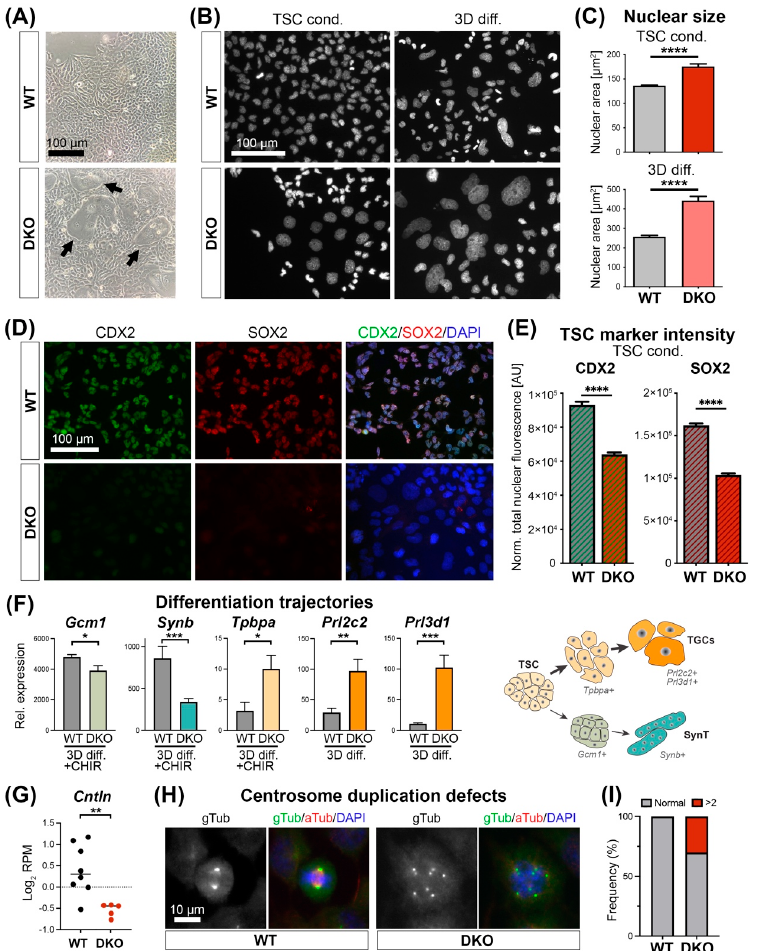
Figure 3. Padi2/3 DKO TSCs exhibit diminished stem cell potential and are prone to differentiate into large trophoblast giant cells (TGCs). ( A ) Phase contrast images of wild-type (WT) and Padi2/3 DKO TSCs. Arrows point to extremely large trophoblast giant cell-like cells in the DKO. ( B ) DAPI-stained nuclei of WT and Padi2/3 DKO TSCs grown under stem cell conditions (TSC cond.) and after 3 days of differentiation (3D diff). Note the extremely large nuclei in the DKO cells even under TSC conditions. ( C ) Independent and unbiased quantification of nuclear sizes in WT and Padi2/3 DKO cells. Statistical analysis by unpaired Student’s t-test (**** p < 0.0001; n = 4 independent clones per genotype with >150 cells assessed each). ( D ) Immunofluorescence staining on WT and Padi2/3 DKO TSCs for trophoblast stem cell markers CDX2 and SOX2. ( E ) Quantification of fluorescence intensities of CDX2 and SOX2 staining. AU = arbitrary units. Statistical analysis by unpaired Student’s t-test (** p < 0.01, **** p < 0.0001; n = 4 independent clones per genotype with >150 cells assessed each). ( F ) RT-qPCRs for relevant trophoblast differentiation markers on WT and Padi2/3 DKO TSC after 3